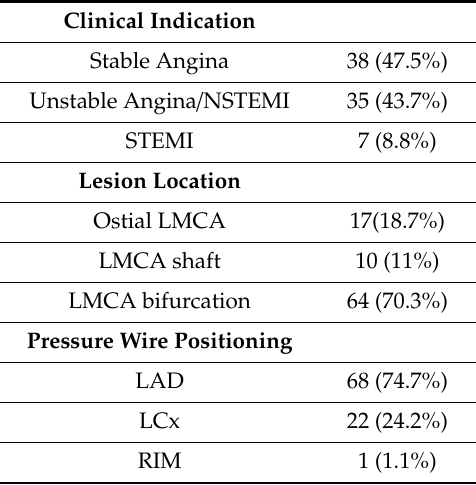
Table 2. Procedural characteristics.